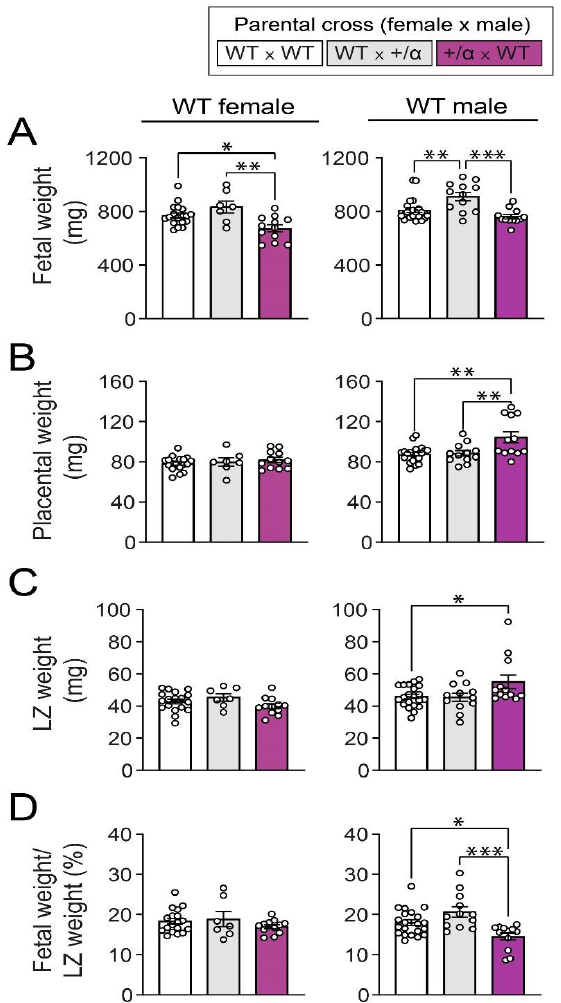
Figure 2. Fetal and placental growth of WT conceptuses in response to littermate and/or maternal p110 α deficiency. Fetal weight ( A ), placenta weight ( B ), LZ weight ( C ), and fetal weight/LZ weight ( D ) in females and males on day 18 of pregnancy. Data are from WT fetuses generated by WT x WT, WT x α/+ , and α/+ x WT parental crosses ( n = 1 – 2 fetuses/sex/dam with 5 – 12 dams/group) and are displayed as individual data points with mean ± S.E.M. Data were analysed by one-way ANOVA with Tukey post hoc pairwise comparisons (* p < 0.05, ** p < 0.01, *** p < 0.001, pairwise comparison). LZ: labyrinthine zone.